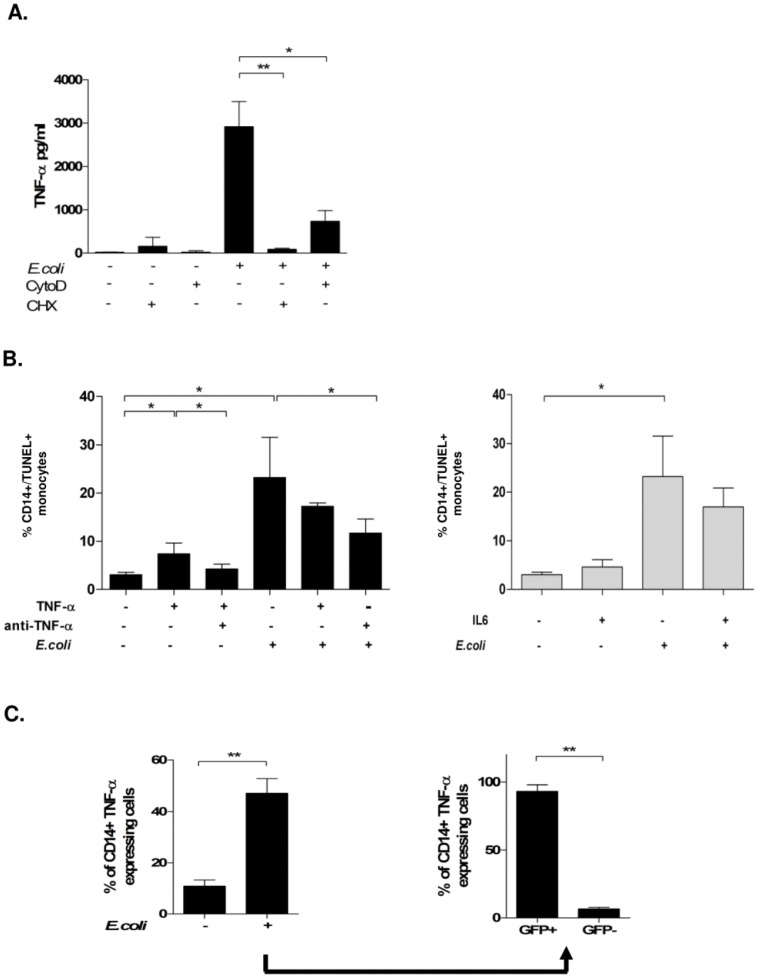
Infection with E. coli induces TNF-α production and monocyte apoptosis in phagocyting and non-phagocyting cells.Monocytes pre-incubated with Cyto D or CHX were infected with E. coli-GFP for 4 hours and TNF-α production was detected in culture supernatants by ELISA (A; n = 8, * p<0.05.) In the same experimental setup, monocyte apoptosis was quantified by TUNEL-staining after treatment with TNF-α neutralizing anti-TNF-α antibody, or E. coli, or combinations (B, left;; n = 9, * p<0.05), or IL-6 (B, right; n = 4, * p<0.05). In the same setup, intracellular TNF-α production of monocytes was analyzed by FACS-stain (C, left) and gated for GFP-positivity (C; n = 5, * p<0.05, ** p<0.001).